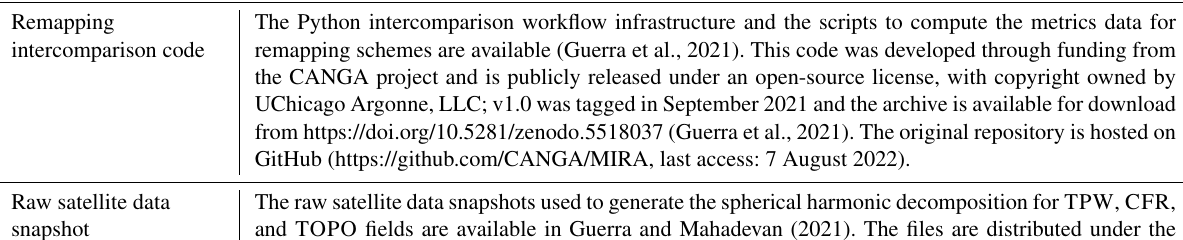
Table 8. Code and data availability. Artifact Availability, license,